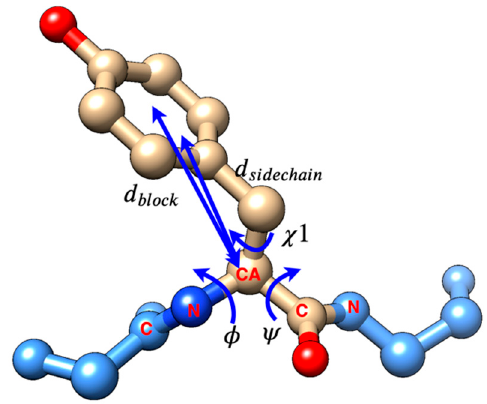
Figure 4. The five features φ , ψ , 𝛘 𝟏 , 𝒅 𝒔𝒊𝒅𝒆𝒄𝒉𝒂𝒊𝒏 and 𝒅 𝒃𝒍𝒐𝒄𝒌 of a protein residue.